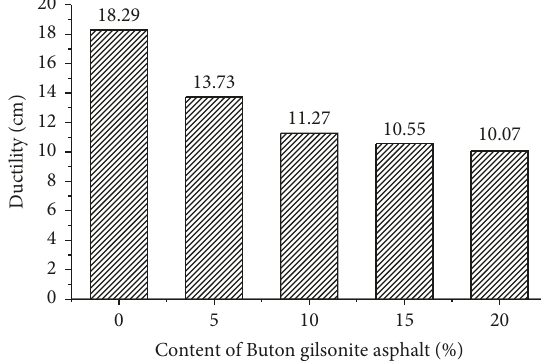
Figure 7: Comparison of low-temperature stability of modified asphalt with different gilsonite